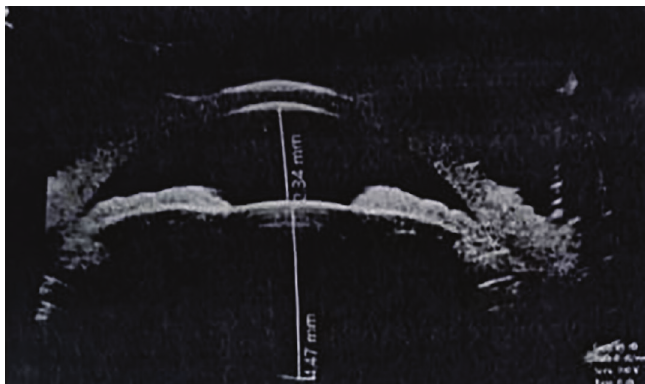
Figure 4 - Ultrasound biomicroscopy of the right eye, the angle of the anterior chamber is narrow.